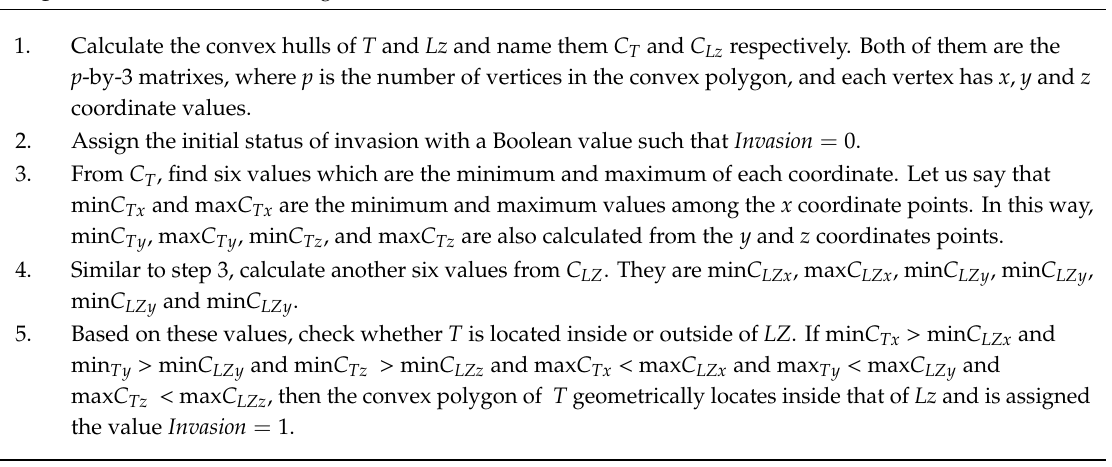
Algorithm 1. Invasion checking